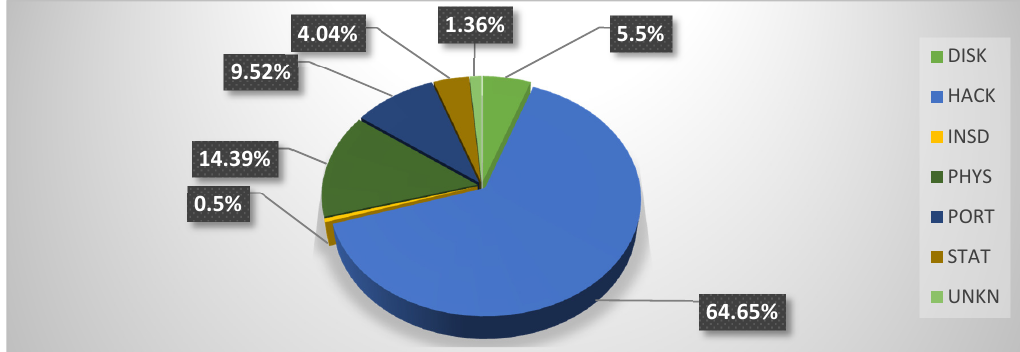
Figure 2. Proportion of Records Exposed From 2005–2019 with Different Types of Attack.